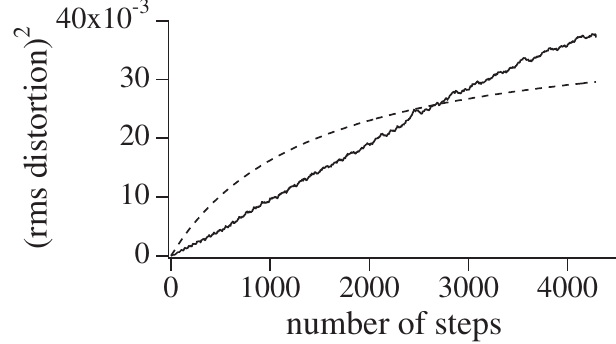
FIG. 17. Evolution of the square of rms optics distortion. There are 4284 ( (cid:2) 84 cells (cid:5) 51 turns) steps. The solid curve is simulation results and the dashed curve is the random walk model.